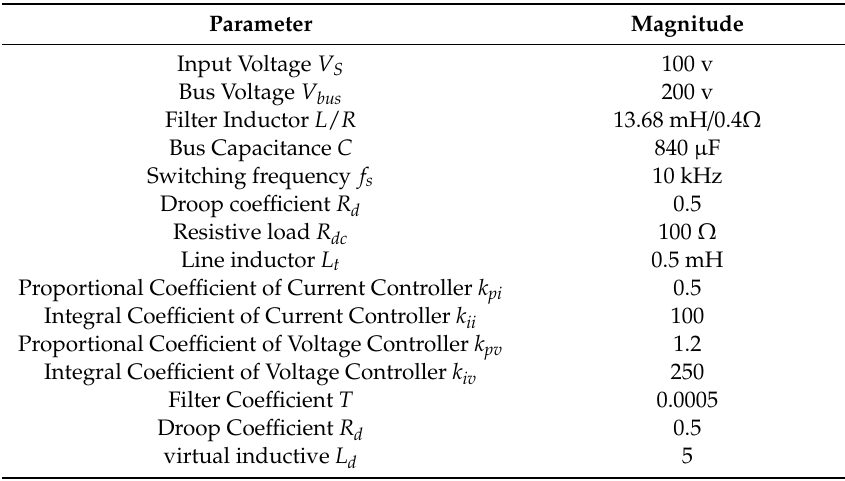
Table 1. Parameters of DC microgrid system.